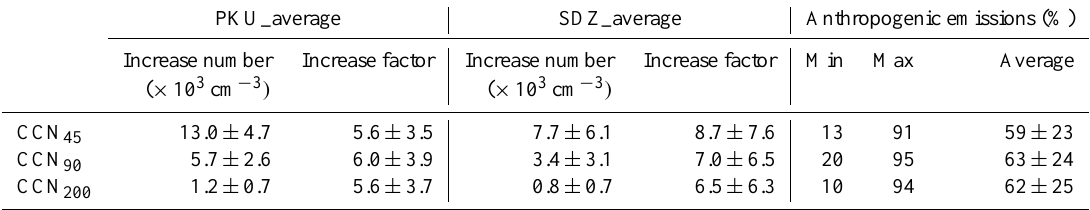
Table 3. Statistics of three quantities (CCN 45 , CCN 90 and CCN 200 ) at two sites and the potential contributions of anthropogenic